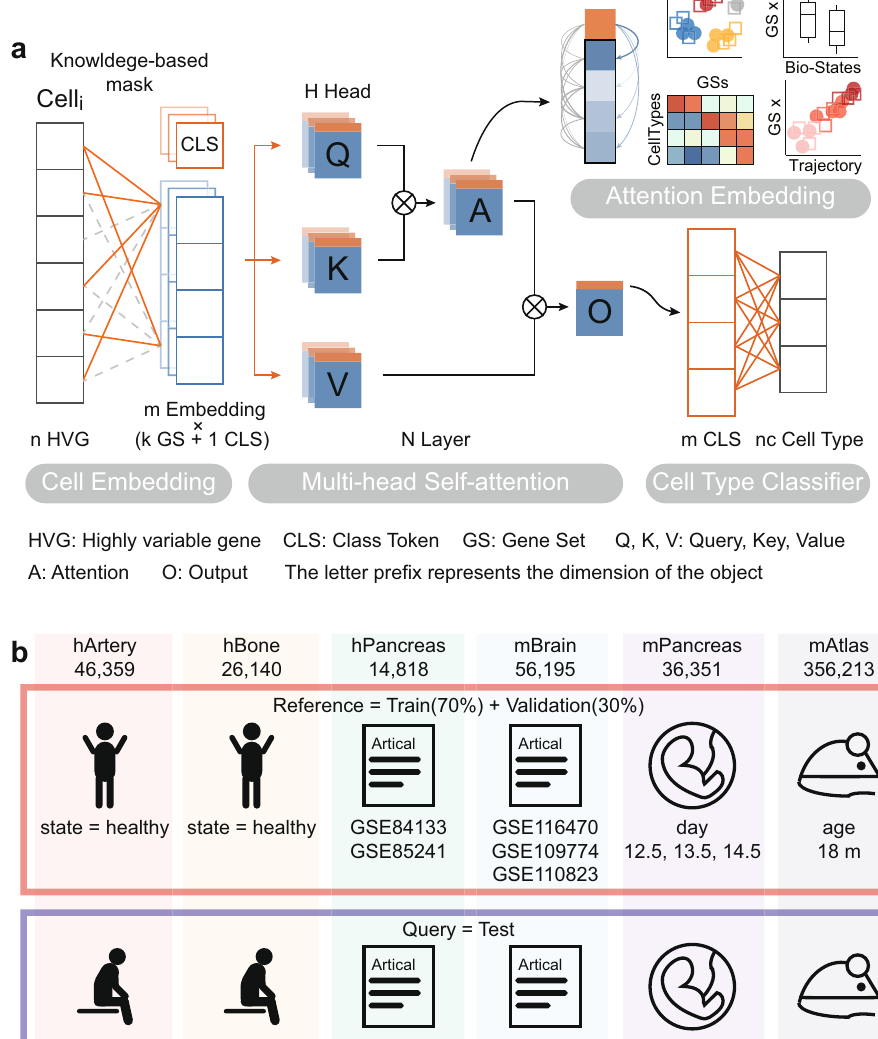
head Self-attention layer, the attention function is performed H times in parallel. The CLS of O, considered aslatent space of each cell, is used asinput of the whole conjunction neural network cell type classi fi er. Meanwhile, the attention of class (CLS) token to gene set (GS) tokens is referred as attention score and used for cell embedding. b hArteryandhBonedatasetsusehealthysamplesastrainingdataand predict disease samples. hPancreas and mBrain datasets are split by data source. Training and test data in mPancreas and mAtlas come from different